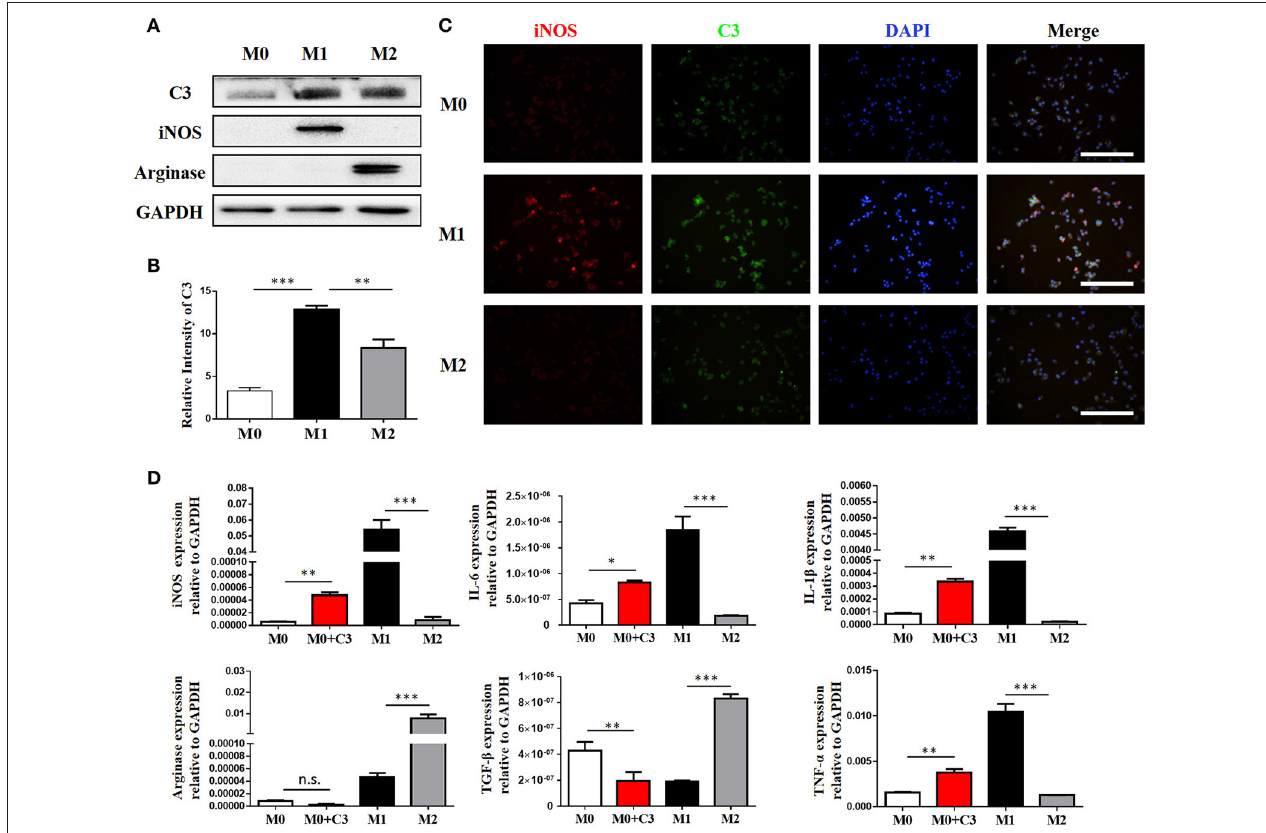
FIGURE 3 | Macrophages are the major source of C3 in the obstructed kidney. (A) The protein isolated from BMMs treated for 24h with either IFN- γ or IL-4 were analyzed by Western blot analyses, and (B) the histogram shows the relative intensity for each marker normalized to GAPDH. (C) Immunofluorescence staining showing increased C3 (green) primarily expressed in M1 with colocalization with iNOS (red) (original magnification × 400). Scale bar, 50 µ m. (D) The effect of exogenous C3 on the subtype of macrophage by real-time PCR. The histogram shows the relative mRNA levels of iNOS, IL-6, IL-1 β , Arginase, TGF- β , and TNF- α in these groups. n = 3. The error bars represent the SEM. * P < 0.05; ** P < 0.01; *** P < 0.001. The data were pooled from three independent